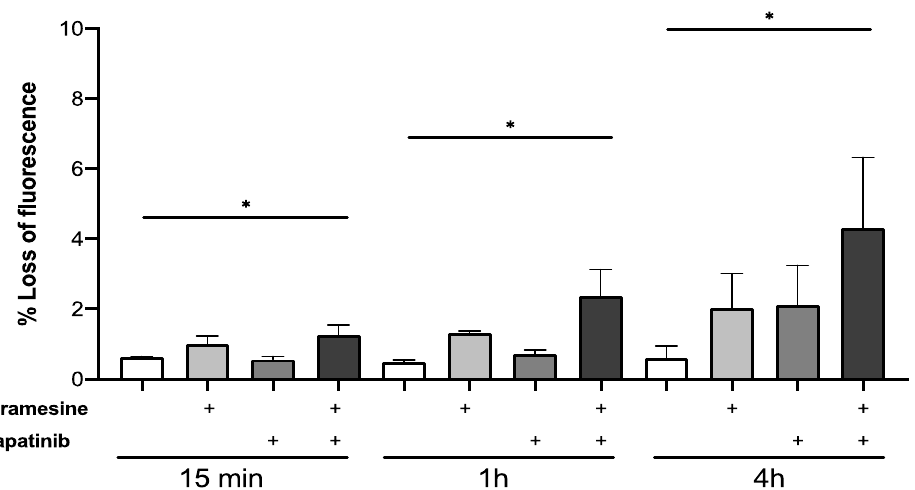
Figure 6. Siramesine and lapatinib induce lysosomal membrane permeabilization in PC3 cells. PC3 cells were treated with siramesine alone (10 μ M), lapatinib alone (0.5 μ M) or in combination for 15 min, 1 h and 4 h. Cells were stained with Lysotracker red (50 nM) for 30 min at 37 °C after treatment. LMP was quantified by flow cytometry where loss of fluorescence indicates lysosome membrane disruption. Results are representative of at least three independent replicates ( n = 3).* represents a p value < 0.05.